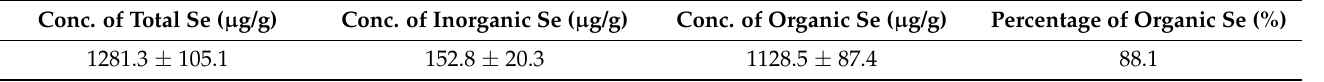
Table 2. Contents of inorganic selenium and organic